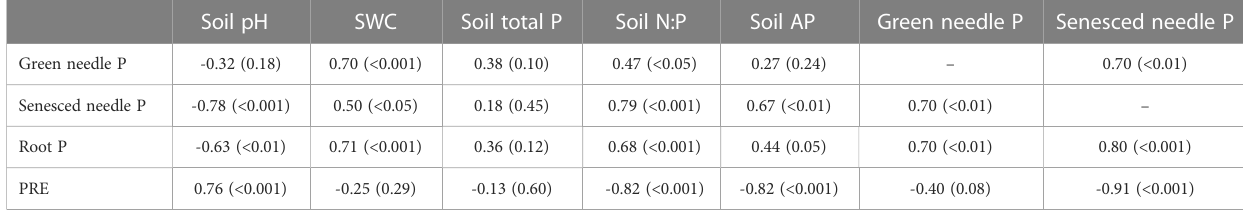
TABLE 4 Pearson correlations between phosphorus resorption ef fi ciency (PRE) and P content in plant and